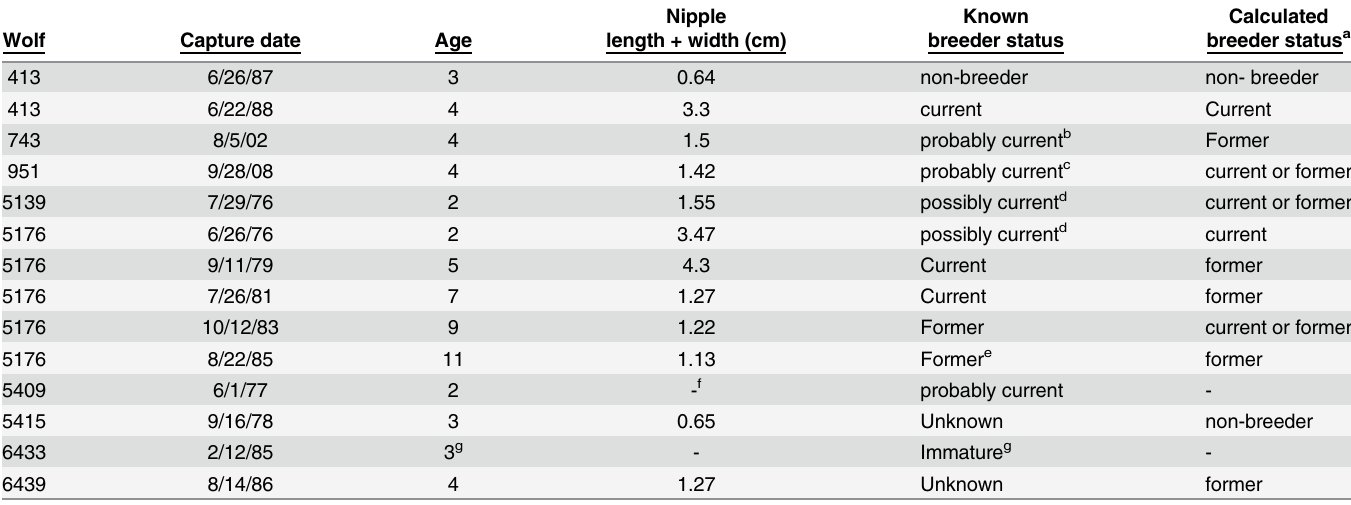
Table 2. Information about known-age female wolves (cid:1) 2-years old in the Superior National Forest, Minnesota captured from 1972 to